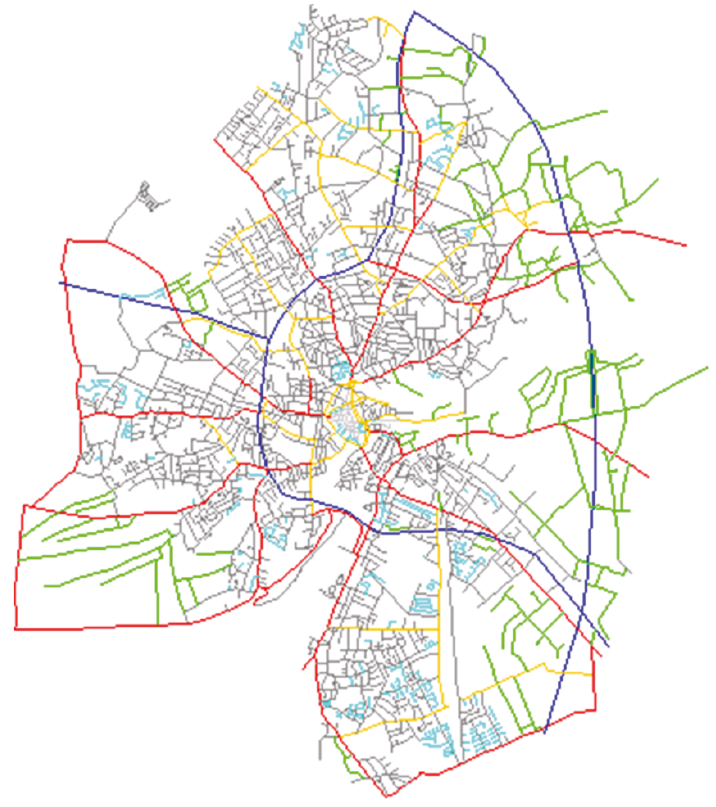
Figure 3: The experimental data sets are generated based on the city and its vicinity in